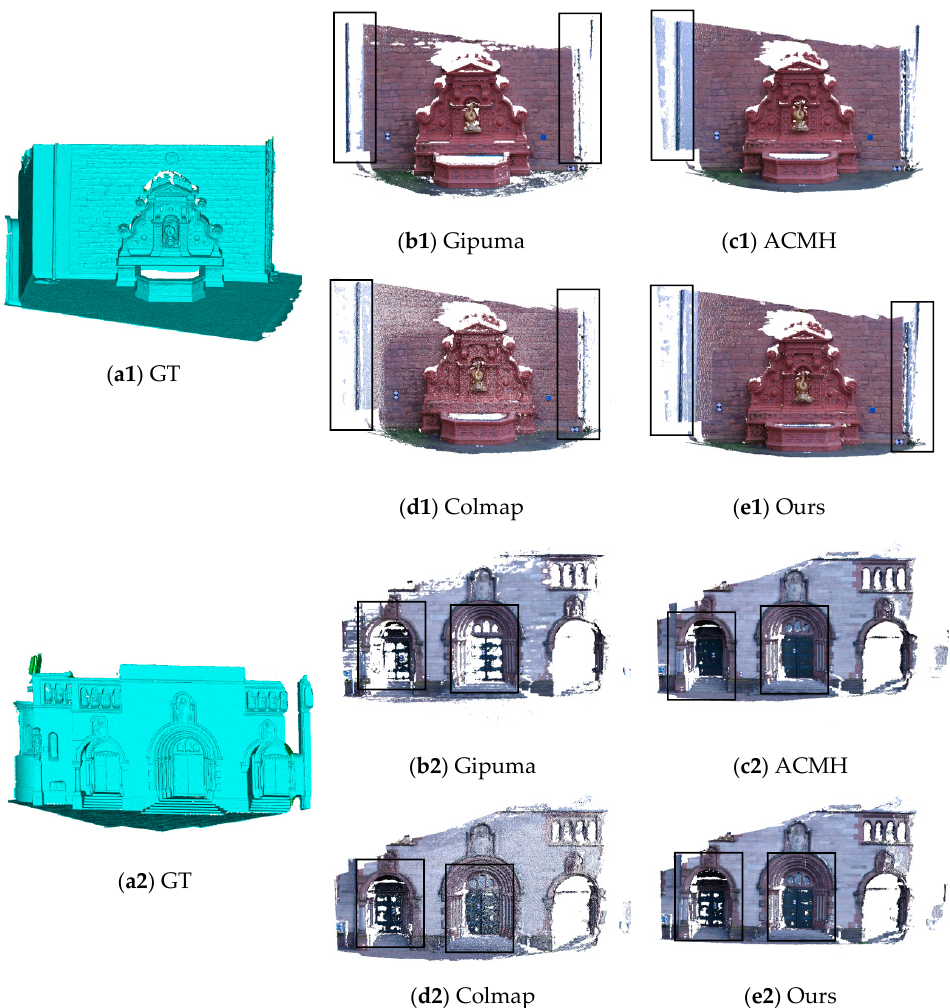
Figure 11. The comparison of reconstructed point clouds with the Strecha dataset. ( a1 , a2 ) are the ground truth meshes of the Fountain and Herzjesu datasets, respectively. ( b1 – e1 ) and ( b2 – e2 ) are generated by Gipuma, ACMH, Colmap, and the proposed method with the Fountain and Herzjesu datasets, respectively.